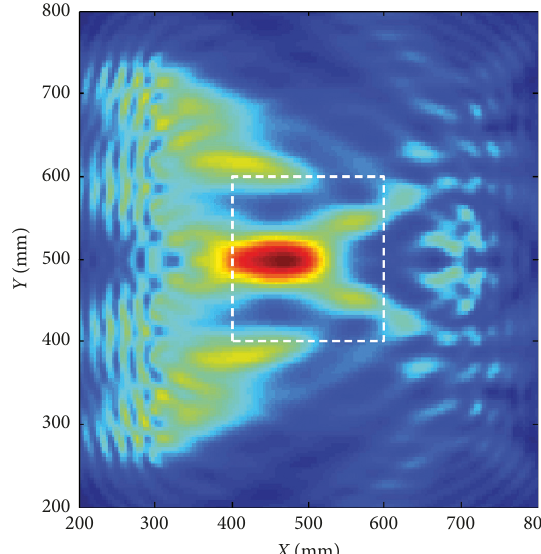
Figure 8: TDTE imaging results (finite element simulation).